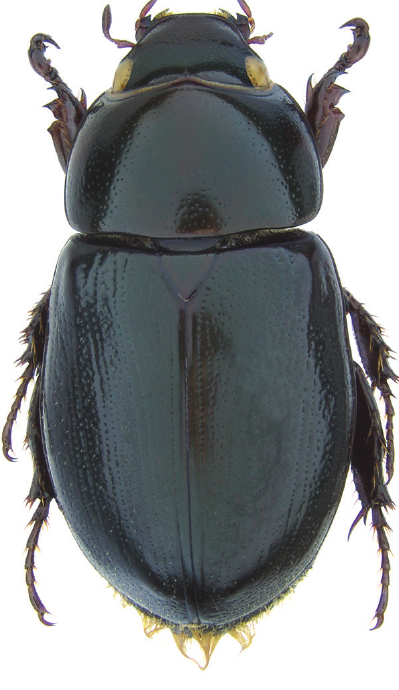
Figure 1. Holotype, dorsal view, of Chalepides pantanalensis Ratcliffe & Seidel, sp. nov.